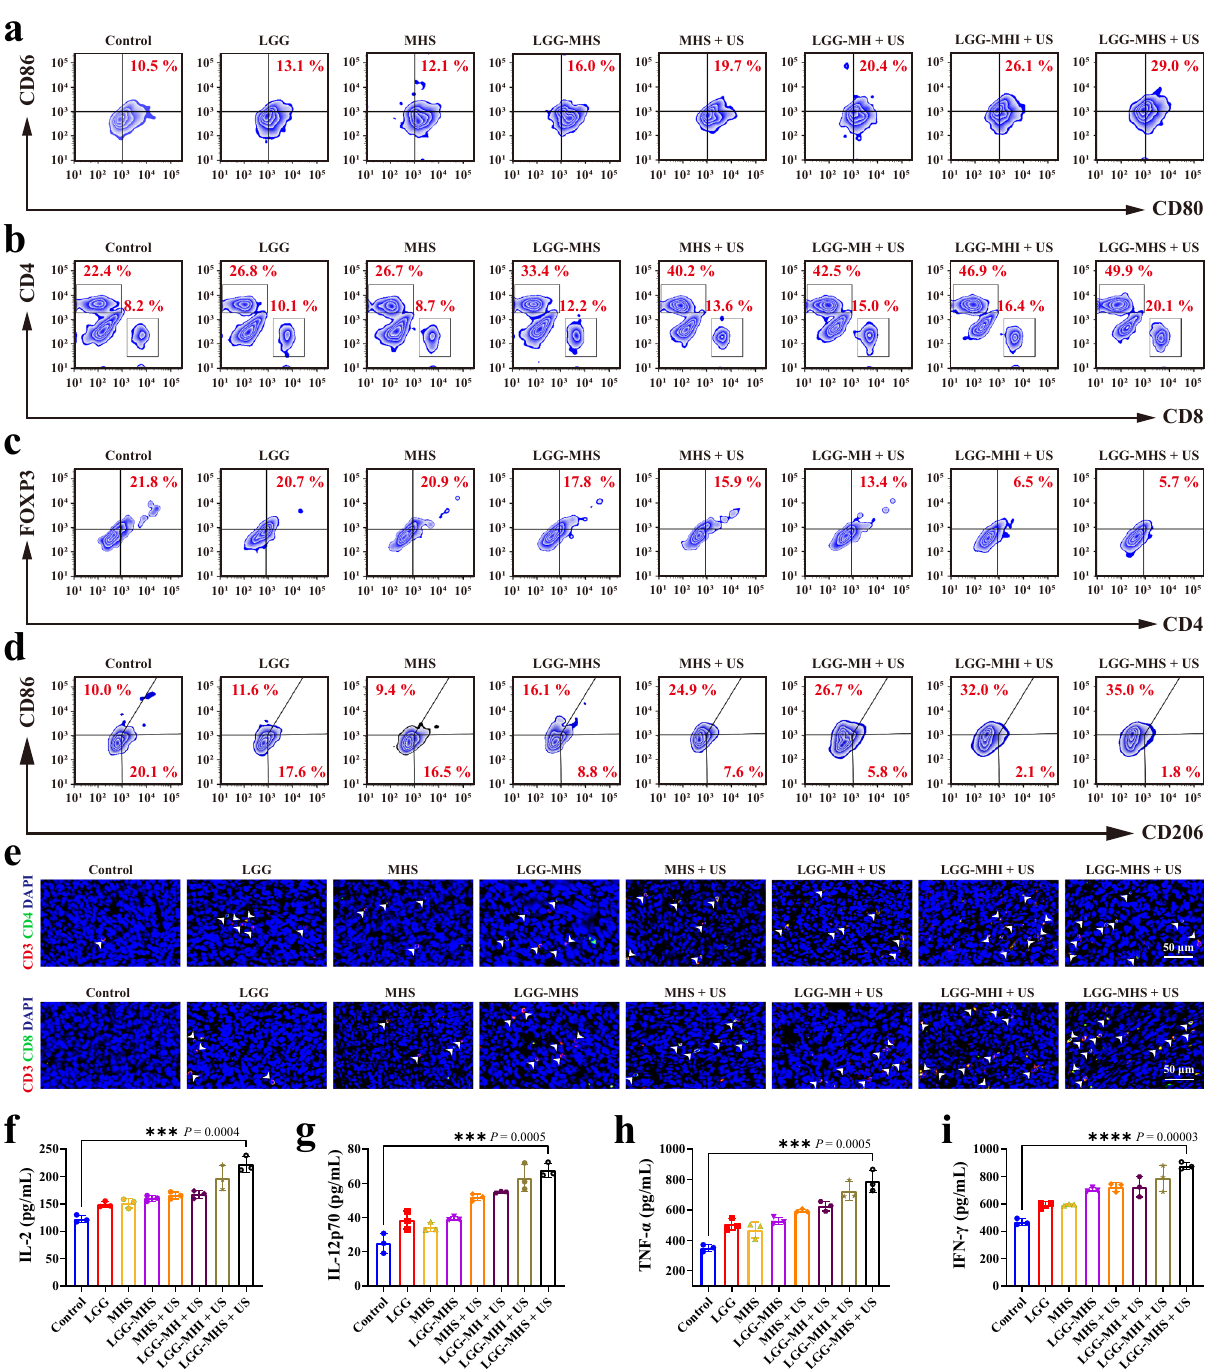
Fig. 7 | Reprograming ofthetumorimmunosuppressive microenvironment by the self-driven LGG-MHS+US nanosystem. a Typical fl ow cytometric of mature DCs in tumor tissue after 24h after the fi rst different treatments. b Typical fl ow cytometric of T cells of CD4 + and CD8 + T cells inthe spleen after 24h afterthe fi rst different treatments. c Typical fl ow cytometric of Tregs in primary tumor tissue after 24h after the fi rst different treatments. d Representative fl ow cytometric of M2 macrophages in spleen after 24h after the fi rst different treatments. e Immuno fl uorescence images of helper T lymphocytes (CD3 + CD4 + ) and